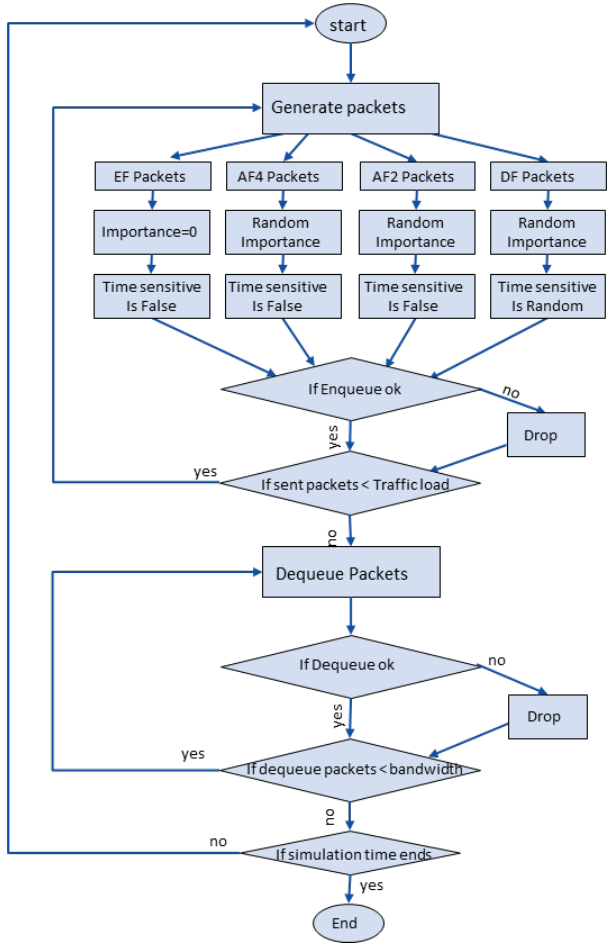
Figure 3. QoS implementation with the triple-metric-based Active Queue Management.